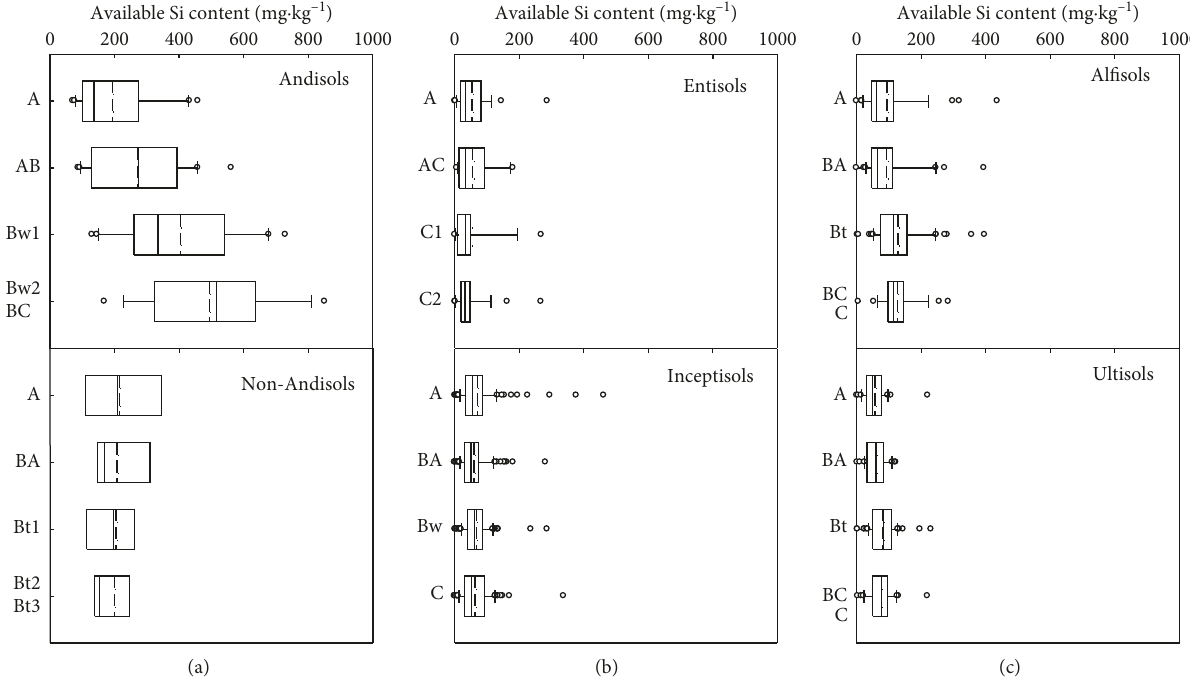
Figure 5: Comparison of available Si content among soil orders in typifying pedons of Jeju soils (Andisols and non-Andisols) and Korean mainland soils (Alfisols, Ultisols, Entisols, and Inceptisols). Boxes represent 25th, 50th (median), and 75th percentiles, and the whiskers indicate the minimum and maximum values. Mean values (dashed line); outliers ( o